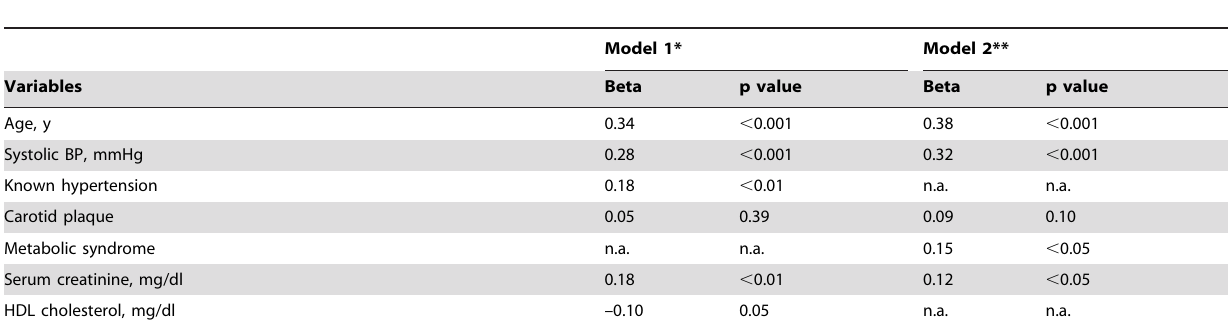
Table 4. Independent covariates of higher PWV in multivariate linear regression